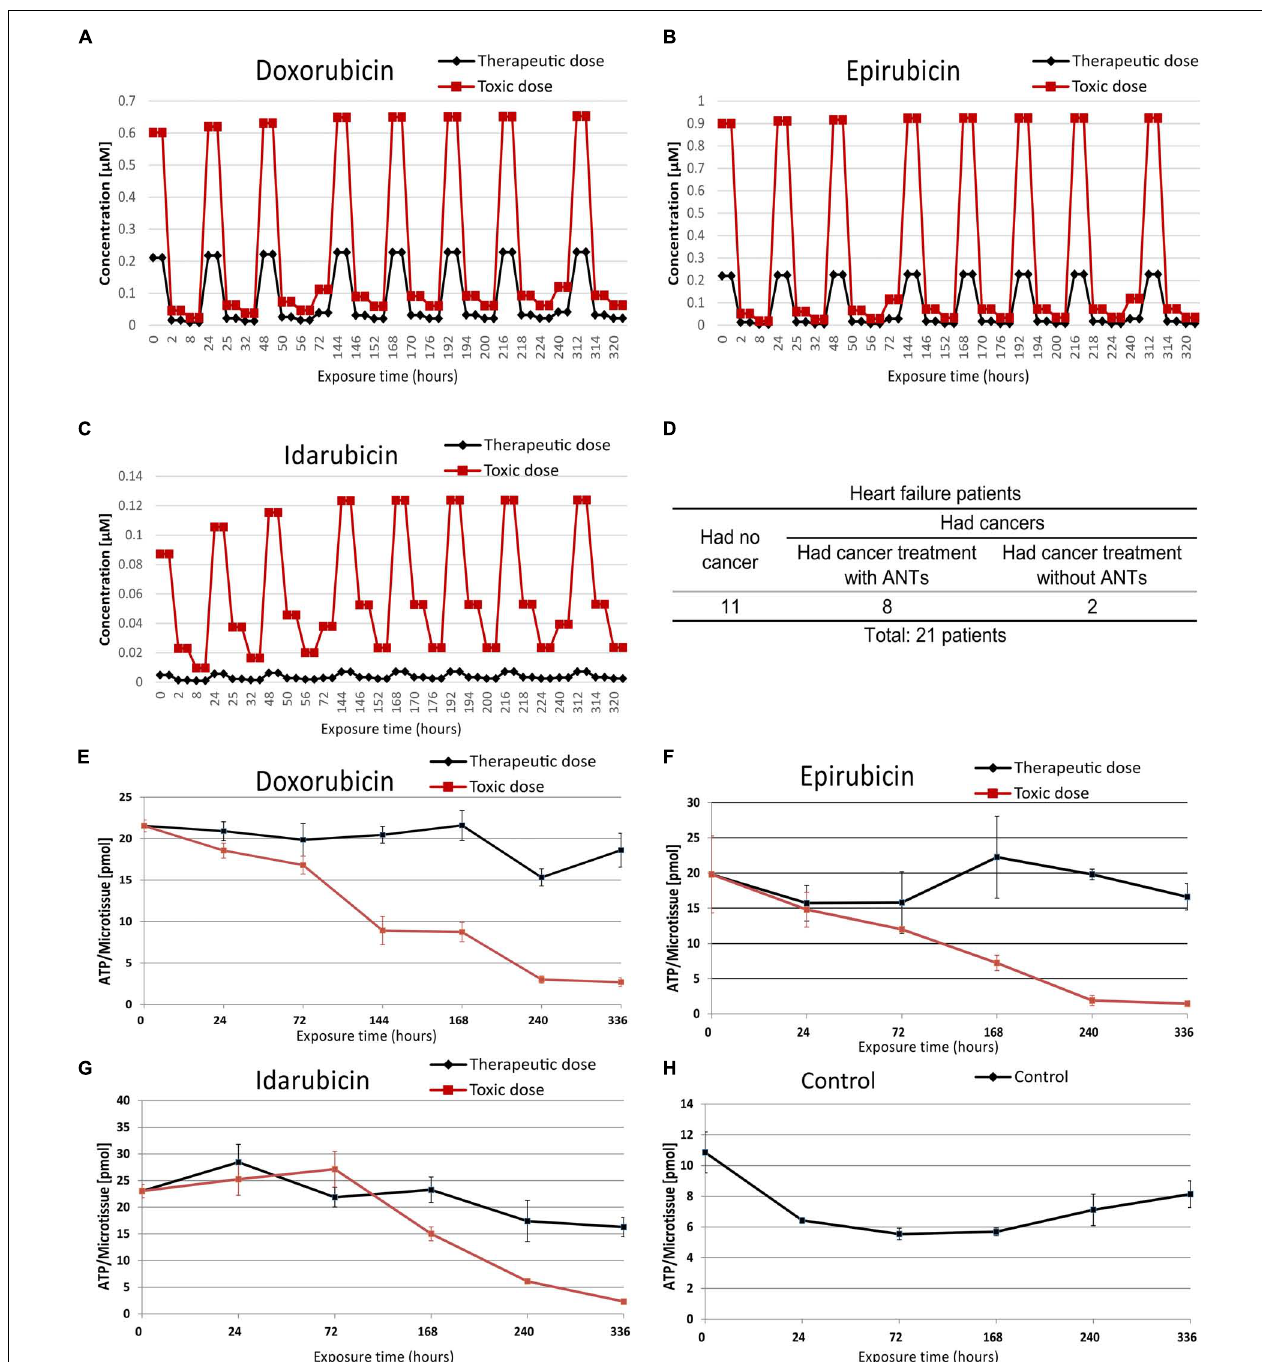
FIGURE 1 | The in vitro microtissue and biopsies samples information. The therapeutic and toxic concentration profiles of doxorubicin (A) , epirubicin (B) , and idarubicin (C) that were used in the cardiac microtissue experiment. Profiles of biopsy samples were taken from heart failure patients (D) . The ATP contents of microtissues were treated with doxorubicin (E) , epirubicin (F) , idarubicin (G) , and control sample (H) .